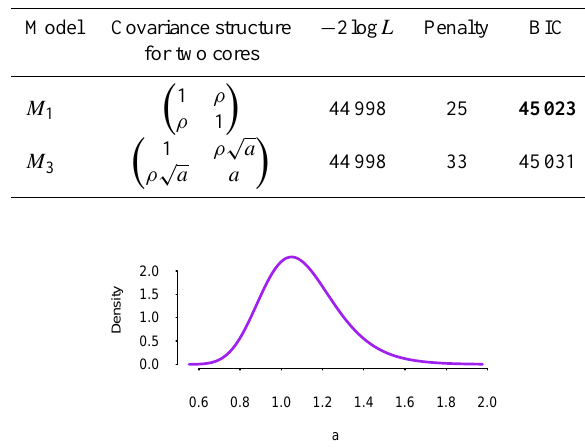
Figure B1. Plot of the smoothed marginal posterior distribution of Figure 8. Plot of the smoothed marginal posterior distribution of the parameter a in the covariance matrix of the parameter a in the covariance matrix of model M 3 described model M 3 described in App. B. The mode is roughly 1 which suggests that a is redundant. in Appendix B. The mode is roughly 1, which suggests that a is